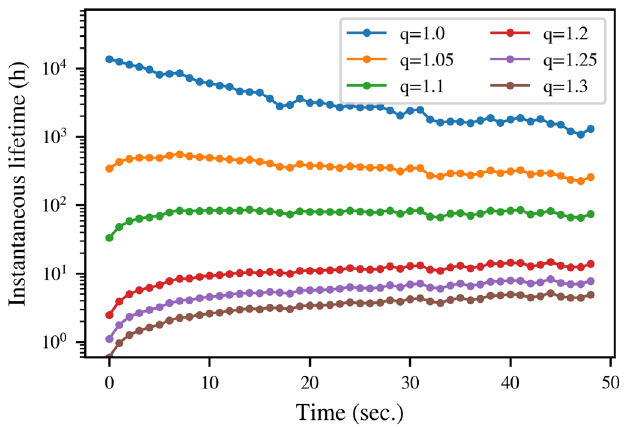
FIG. 15. Instantaneous lifetime computed with q-Gaussian distributions and q ¼ 1 (blue), q ¼ 1 . 05 (orange), q ¼ 1 . 1 (green), q ¼ 1 . 2 (red), q ¼ 1 . 25 (purple), and q ¼ 1 . 3